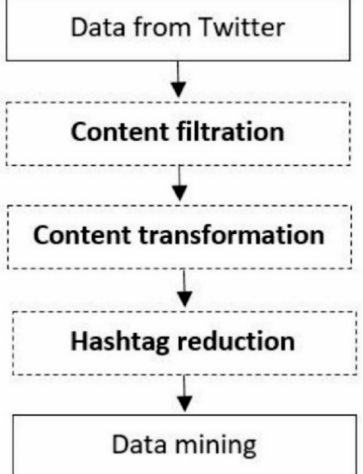
Figure 1. The data analysis process.